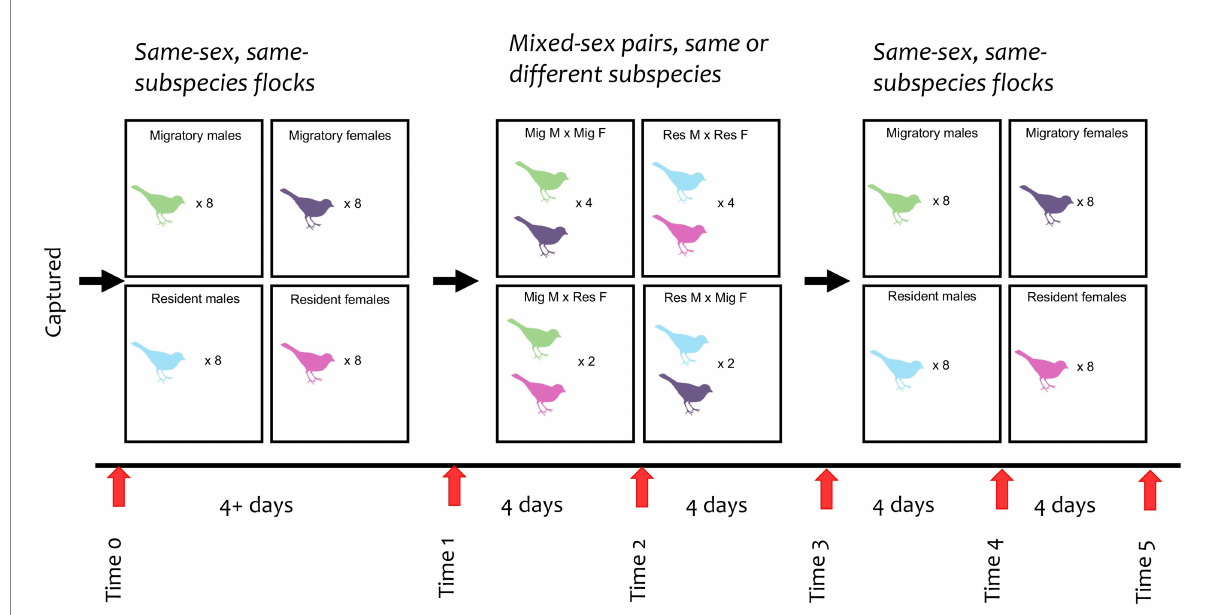
FIGURE 1 Experimental design of junco flocks and pairs from time 0 to 5. Each bird color represents a sex and subspecies (green = migratory male; purple = migratory female; blue = resident male; dark pink = resident female). Numbers within each box indicates the quantity of birds per flock or pair type. All pairs were housed